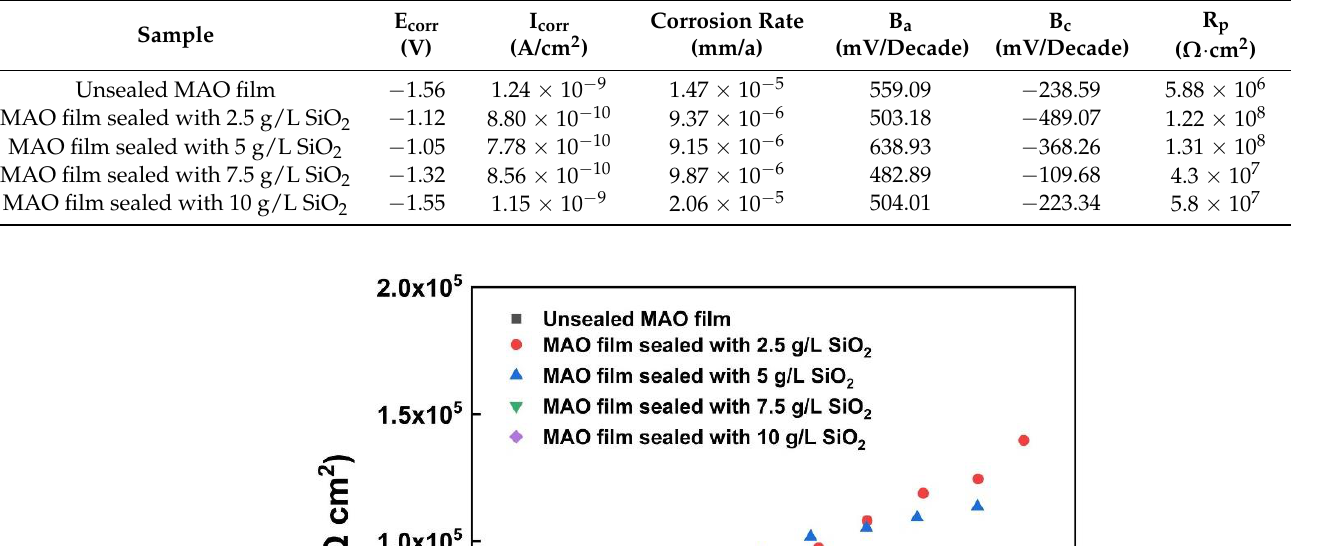
Figure 8. Polarization curves of unsealed MAO film and MAO films sealed by SiO 2 nanoparticles. Table 5. Fitting results of polarization curves.